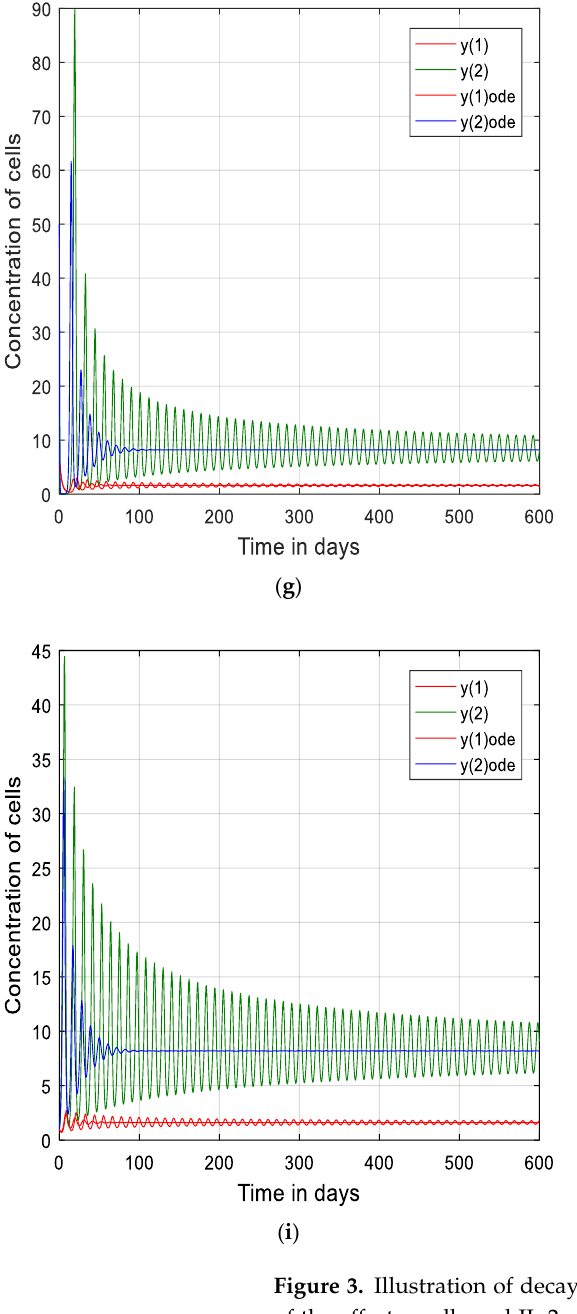
 −−  t y effector cells, and ] )[ (      t y 1 2